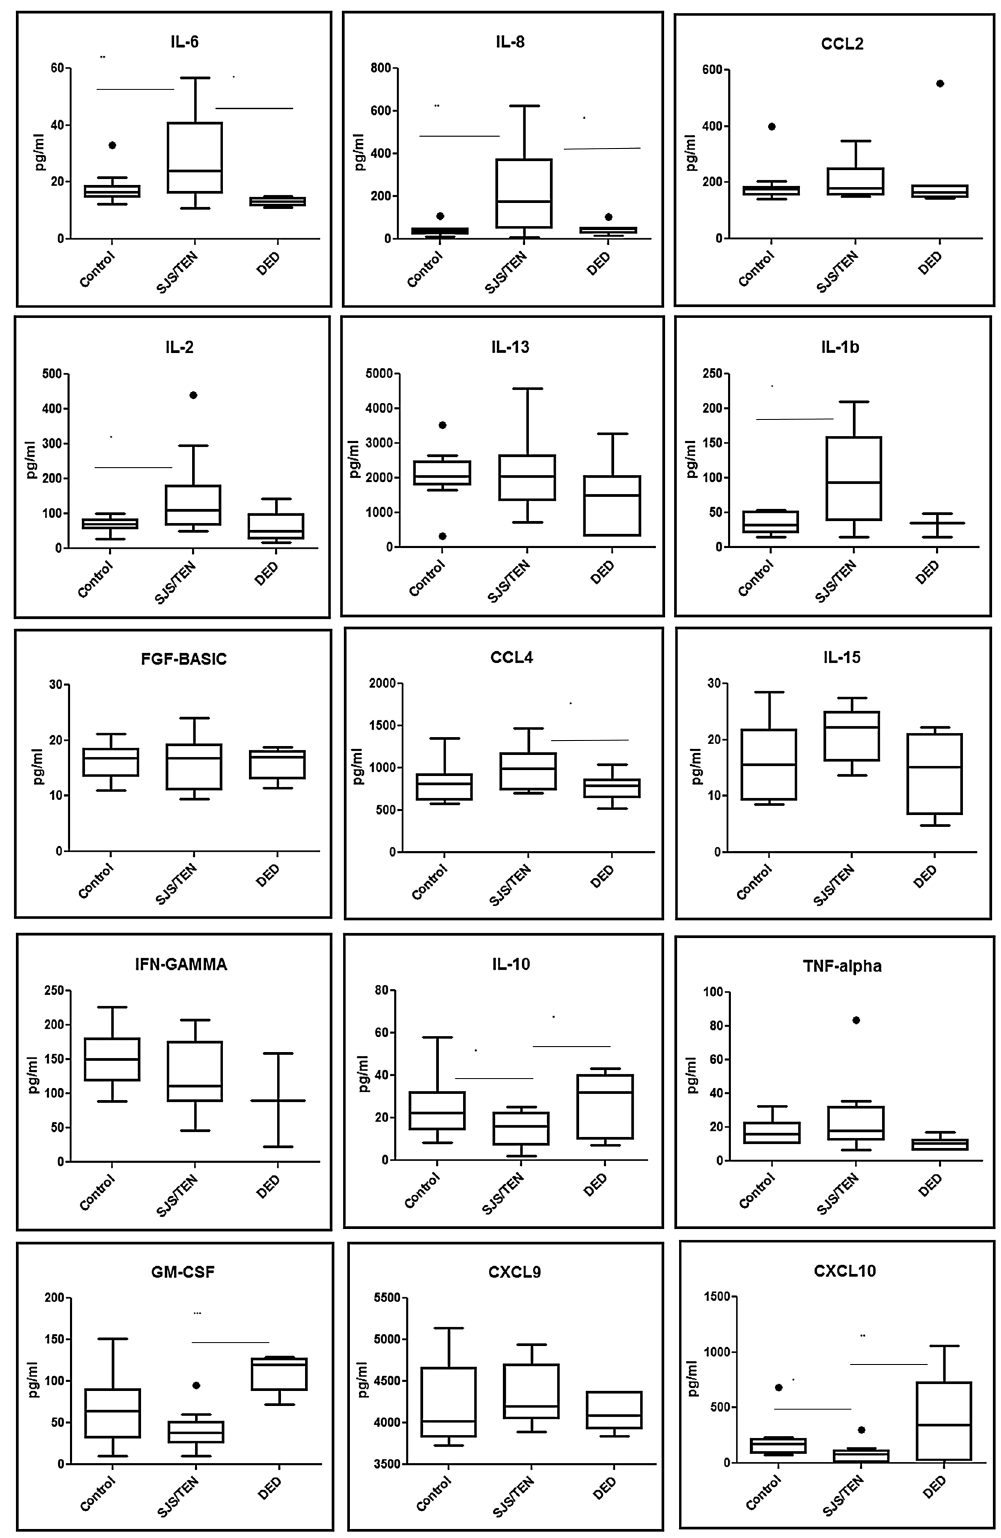
Figure 2. Above figure shows the cytokine analysis in tear samples using multiplex ELISA. The expression of cytokines in chronic SJS tears are compared with the controls and severe DED tears. *p value ≤ 0.05, **p value ≤ 0.01, ***p value ≤